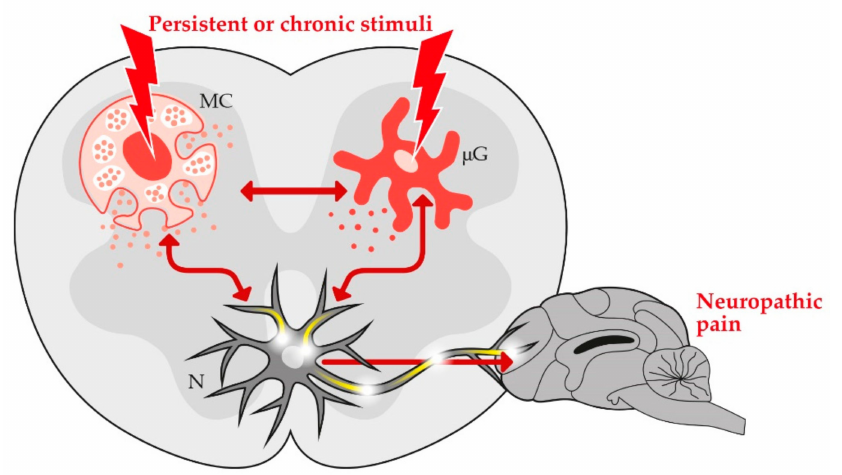
Figure 2. Once hyper-activated spinal microglia and mast cells release a wide variety of media- tors able to induce chronic neuronal hypersensitivity (i.e., central sensitization) and the resulting neuropathic pain. MC, mast cell; µ G, microglia; N,